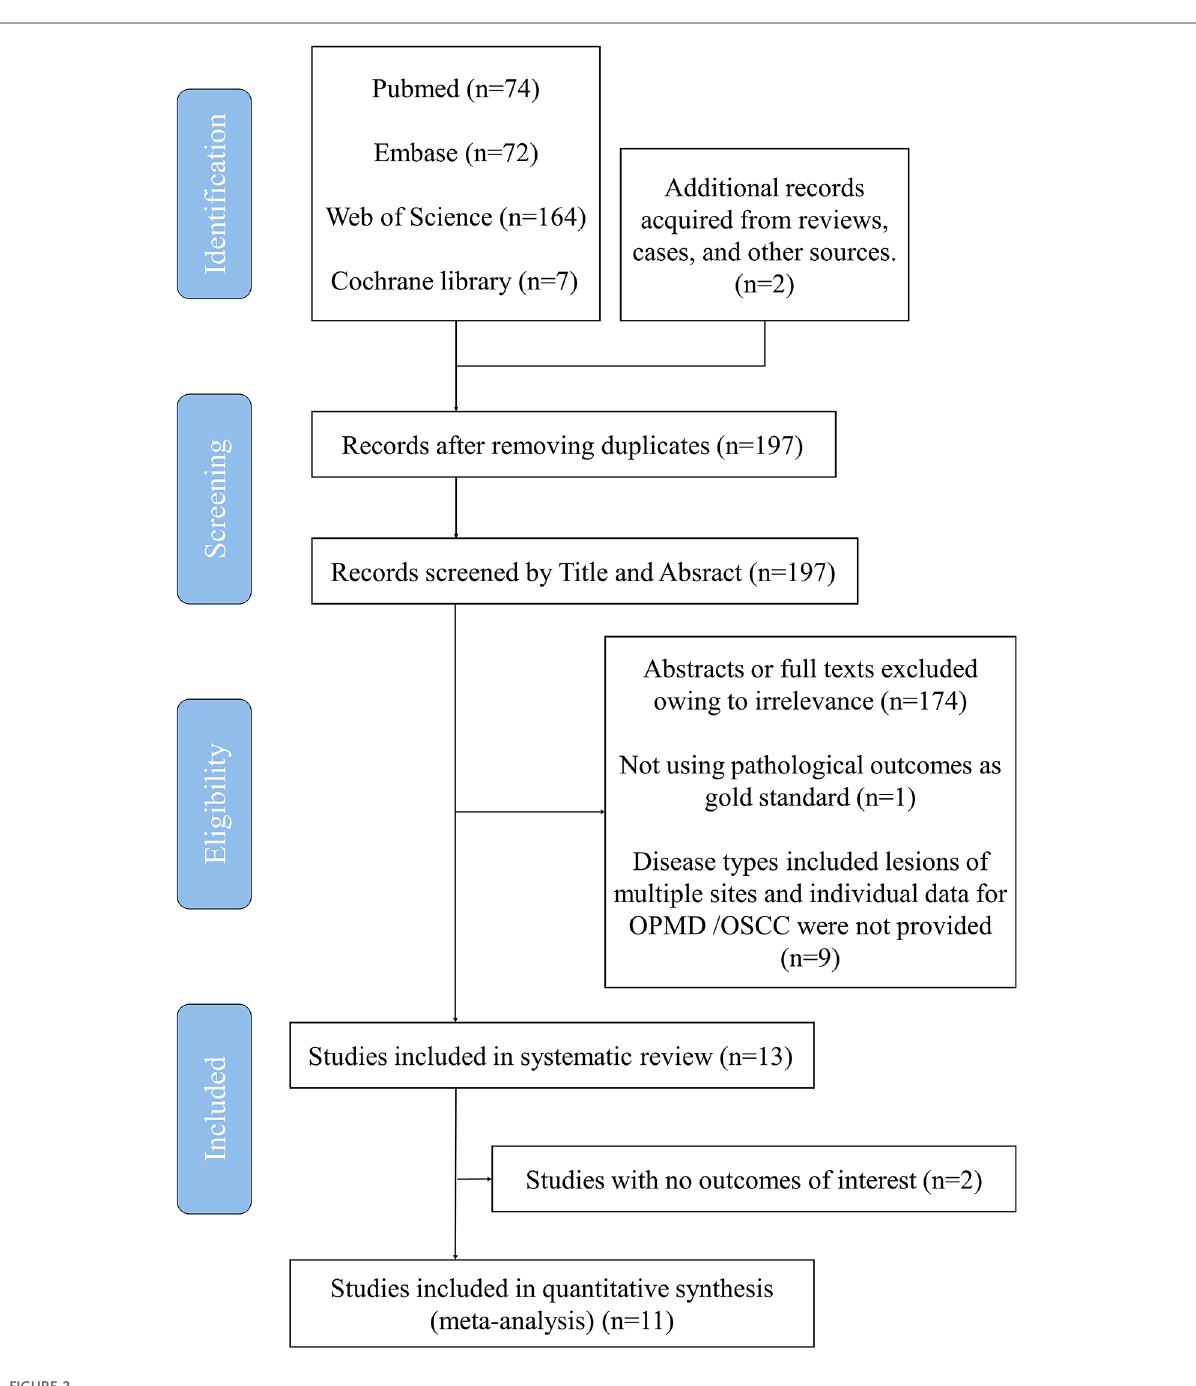
FIGURE 2 Summary of the search strategy of this